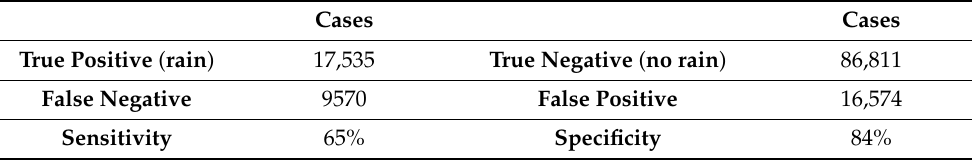
Table 7. Sensitivity and specificity of the model, in the testing part, amounting to 30% of the total data. True Positive days with rain correctly predicted by the model; True Negative days without rain correctly predicted by the model; False Negative days without rain incorrectly predicted; False Positive days with rain incorrectly predicted. Cases Cases True Positive ( rain ) 17,535 True Negative ( no rain ) 86,811 False Negative 9570 False Positive 16,574 Sensitivity 65% Specificity